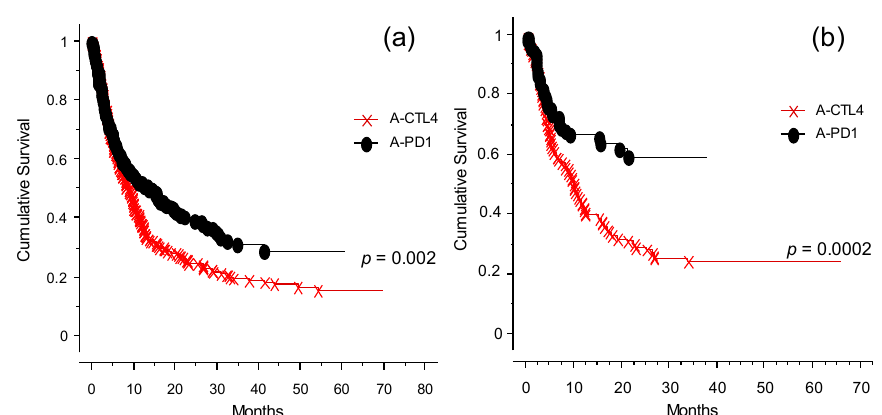
Figure 2. Cumulative survival analysis of patients depending on treatment before enrollment to the ICI program at the INT-NA: ( a ) Survival curve for the whole cohort of patients ( n = 578). ( b ) Survival analysis of patients stratified into five groups based on treatment received before access to the INT-NA’s program: naïve (blue line); immunotherapy (green line), cytostatic (red line), im- munotherapy and target treatment (brown line), and target treatment (purple line). Naïve and immunotherapy groups (non-target) had an OS significant higher compared to the other treatment groups ( p = 0.001) (see also Figure 4a).